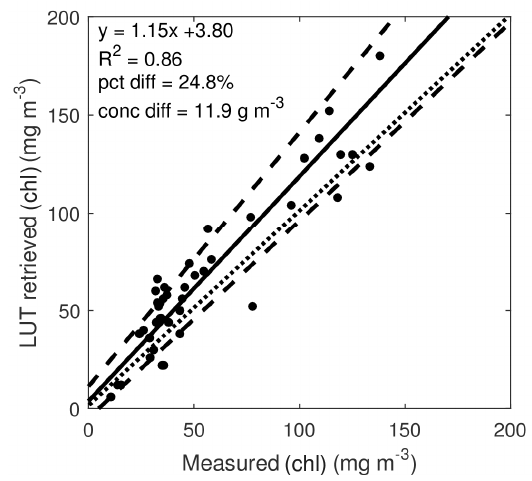
Figure 14. Comparison between measured and look-up table estimated (unconstrained inversion) values of chlorophyll concentrations ((chl)) for selected samples showing fewer features of accessory pigments. The dotted line represents 1:1 line and the dashed lines represent 95% confidence interval.